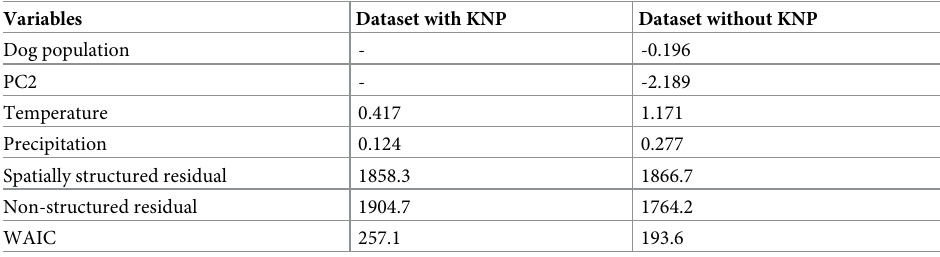
Table 8. Multivariable analysis results for INLA using a zero-inflated convolution models with negative binomial errors for predicting dog rabies cases in South Africa between 2008 and 2012 using datasets with and without Kru- ger National